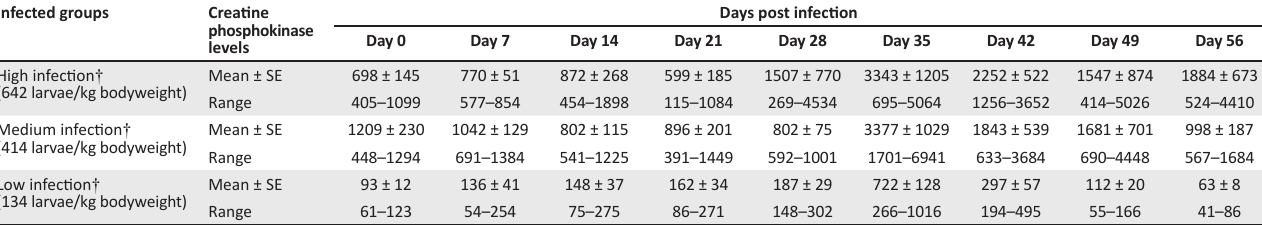
TABLE 5: Mean creatine phosphokinase levels (IU/L) of Nile crocodiles ( Crocodylus niloticus ) experimentally infected with Trichinella zimbabwensis. Infected groups